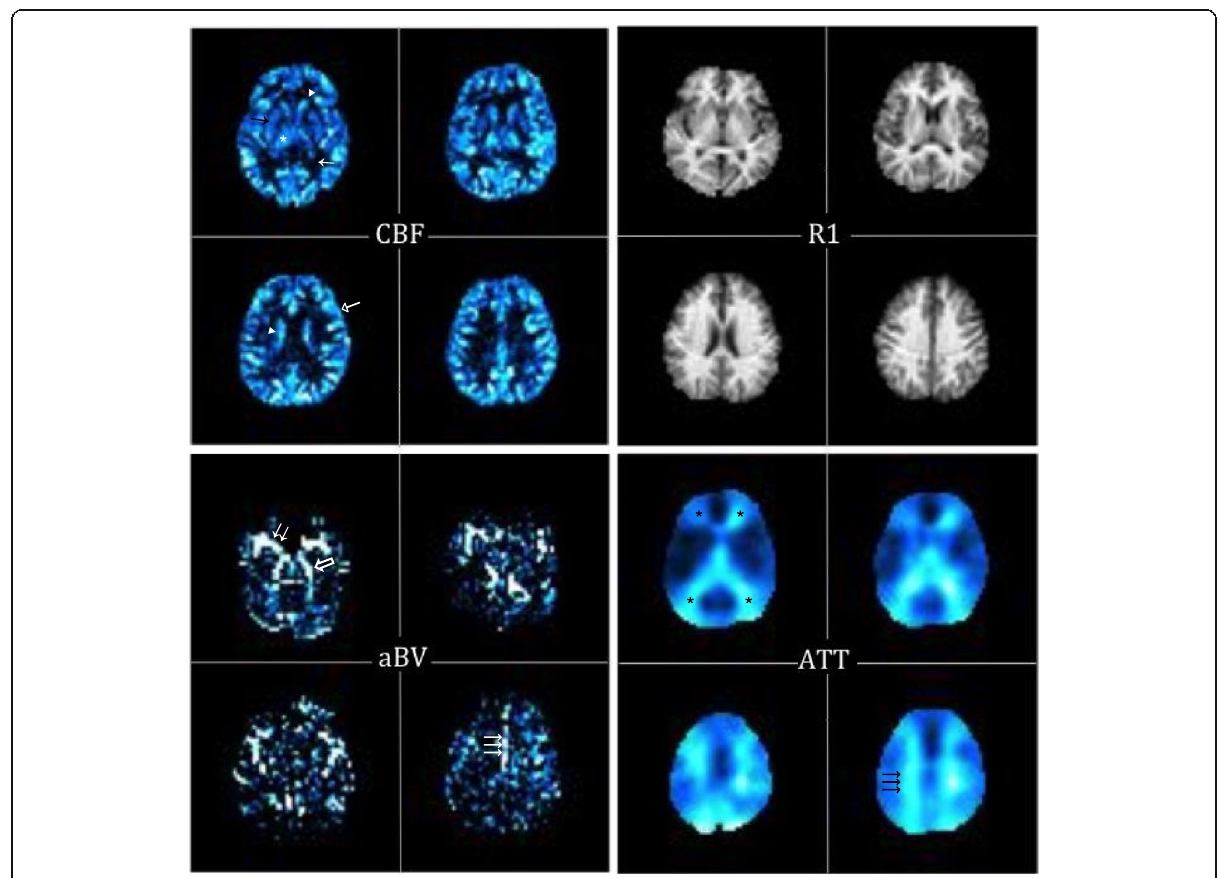
Fig. 1 The cerebral blood flow (CBF) and T1 relaxation rate (R1) maps in the top row show an example of good contrast between the white matter and the cortical and subcortical grey matter: caudate nucleus head and body (arrowheads), thalamus (asterisk), white matter (arrow), grey matter (open-headed arrow). The arterial blood volume (aBV) maps illustrate the larger arterial volume corresponding to the anterior (triple arrow), middle (double arrow) and posterior cerebral (open arrow) arteries. The arterial transit time (ATT) maps show the areas of prolonged ATT in the superficial (asterisks) and deep (triple arrows) watershed